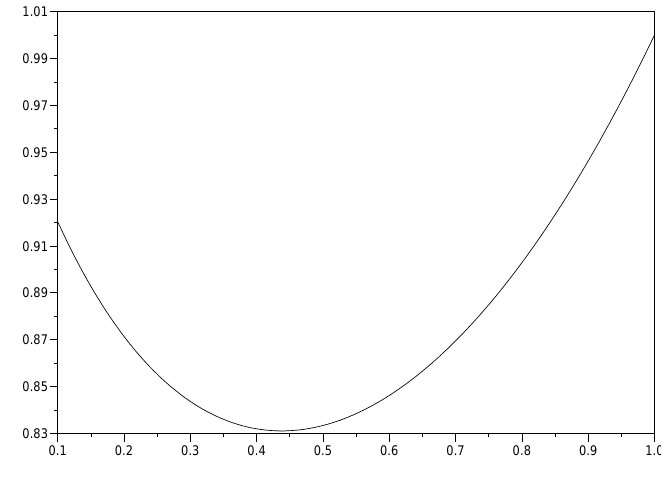
(cid:82) t B H ( s ) ds , given by (20), as a function of H ∈ ( 0,1 ) , 0